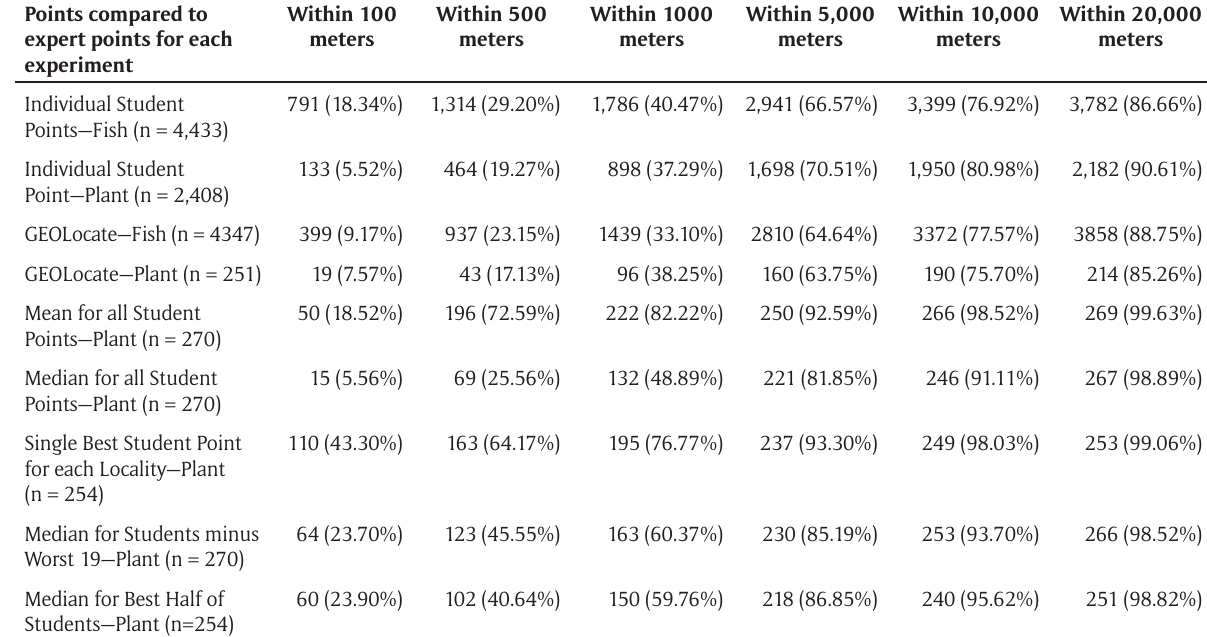
Table 2: Comparison of student points, GEOLocate automated points, and median of student points to expert points measured by absolute distance for the fish and plant experiments. Because relatively few of the collection locations in the fish experiment were georeferenced by multiple students, we do not report comparisons with the consensus student points for that experiment.